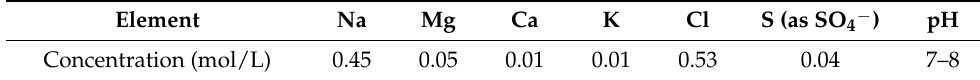
Table 4. Average natural seawater composition—major elements [63]. Element Concentration (mol/L)